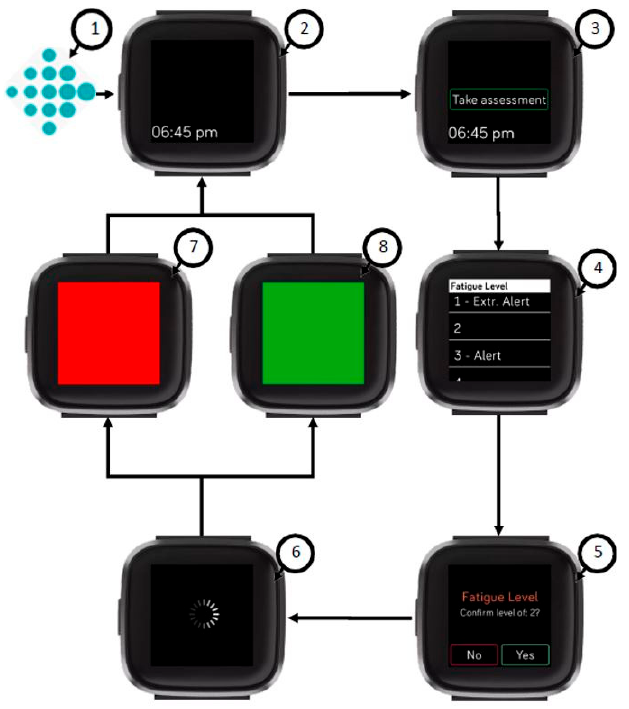
Figure 3. Final system